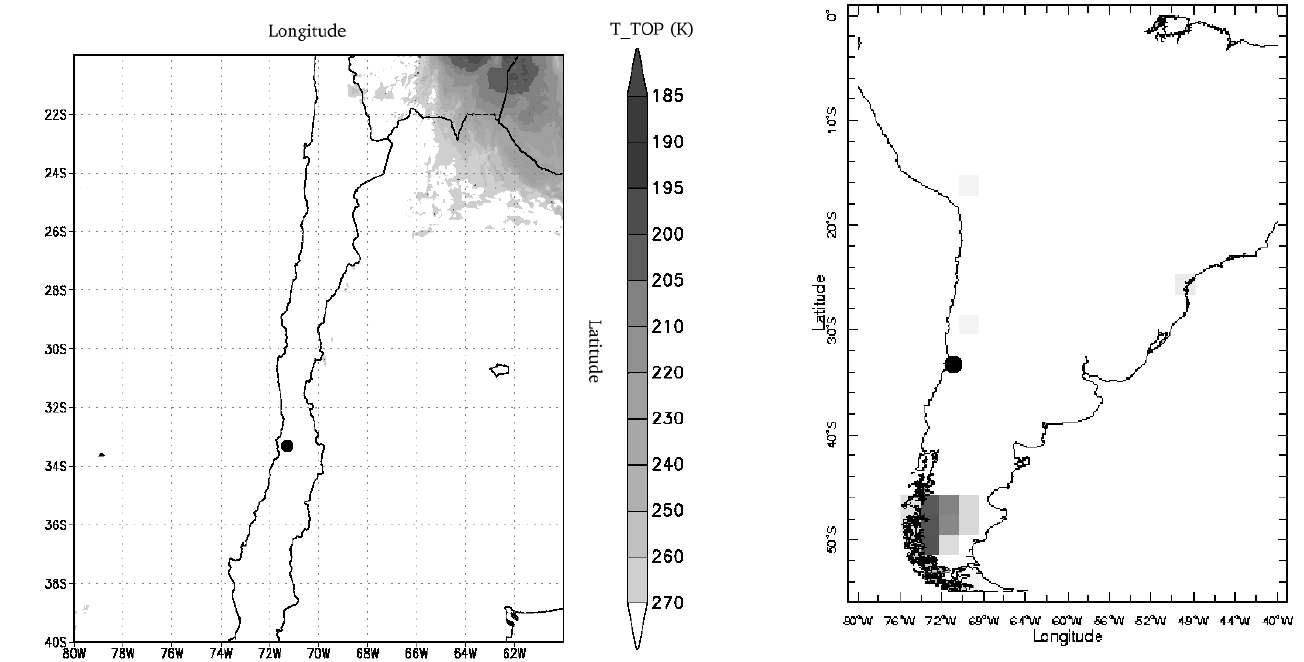
Fig. 5. Case 1: Analysis of convective and topographic IGW sources. Left: GOES satellite data, cloud top temperature field (dark zones indicate tall clouds). Right: NCEP-NCAR reanalysis, daily mean zonal gravity wave drag (darker zones correspond to stronger forcing by gravity waves). The Santo Domingo location is marked by the black dot.